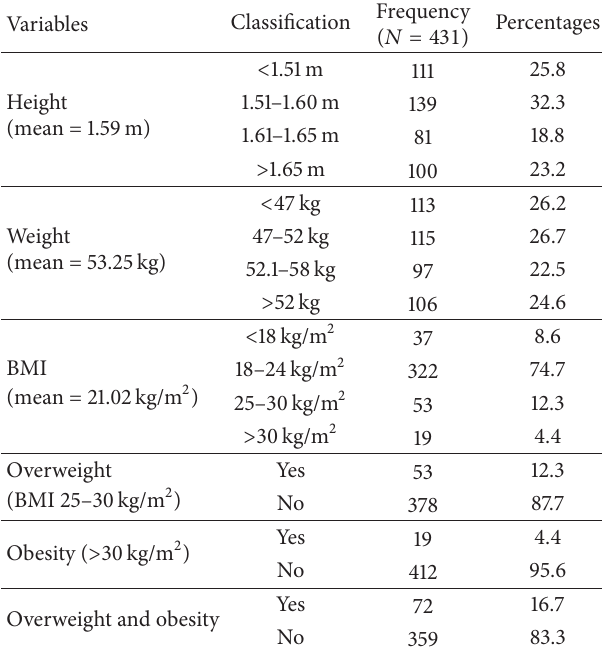
Table 4: Physical measurements of high school students in Bahir Dar city, North West Ethiopia, 2014.